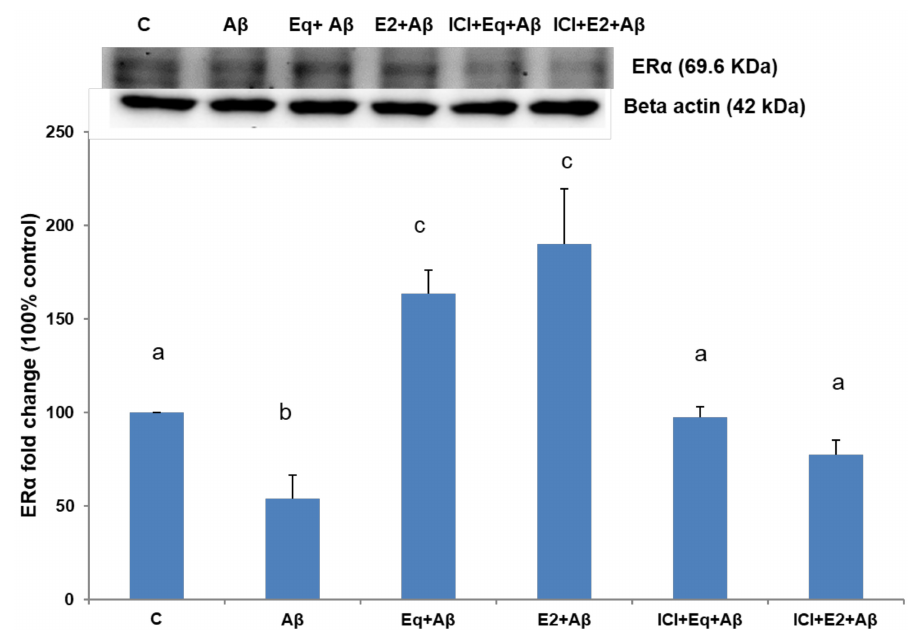
Figure 2. The estrogen receptor alpha (ER α ) expressions of SH-SH5Y cells from di ff erent treatments. Data were analyzed by a one-way ANOVA followed by the LSD post-hoc test and are representative of three independent experiments ( n = 3). Values are presented as the mean + SD. Bars with di ff erent letters are significantly di ff erent at p <